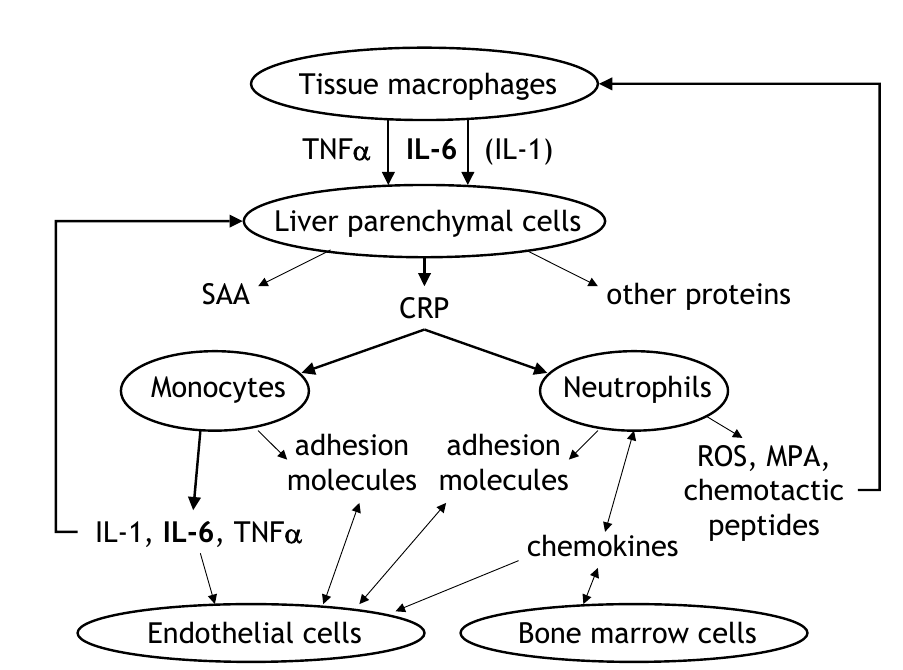
Fig. 5 Hypothetic scheme of CRP-dependent stimulation of monocytes in AP.